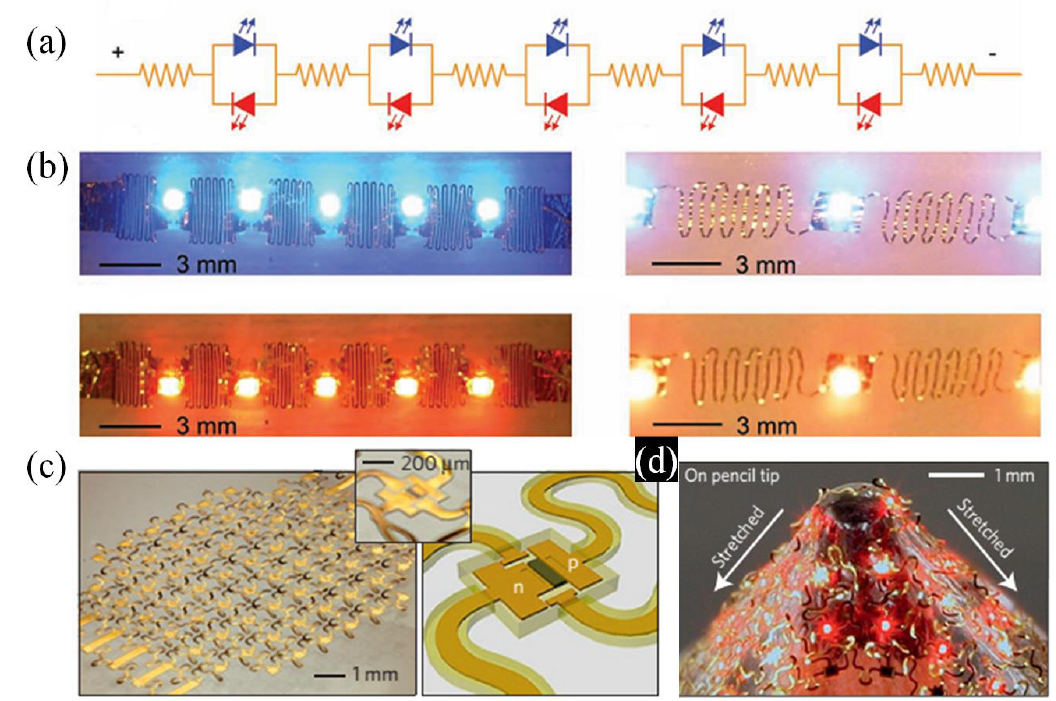
Figure 3: (a) The circuit model of the LED arrays for stretchable EL devices, consisting of blue and red LEDs connected reversibly. (b) The blue or red LEDs were controlled to turn on or off by reversing the applied bias under relax states (left photographs) and under 140% strain (right photographs). Reproduced with permission from [57]. (c) An optical image of an array of µ-ILEDs connected by non-coplanar serpen- tine metal bridges on a PDMS substrate. The right image is a schematic illustration of a single device with a representative device shown in the inset photograph. (d) An optical image of the stretchable EL device conformably attached onto a sharp pencil tip. Reprinted with